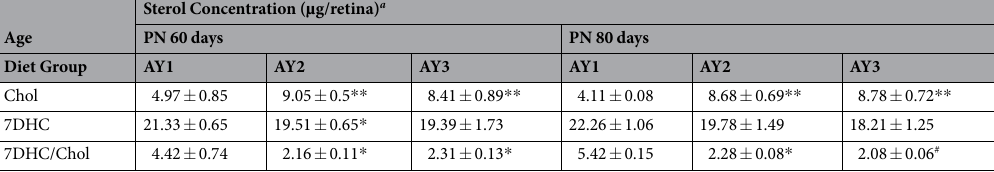
Table 1. Effect of a high-CHOL diet, with or without antioxidants, on retina neutral sterol levels in AY9944- treated rats. aValues determined by UHPLC-MS/MS as described in Methods . N = 3 biological replicates per condition. Statistical significance (Student’s t -test), relative to AY1 values: * p < 0.05; ** p < 0.005 relative to AY1. # p < 0.05 between AY2 and